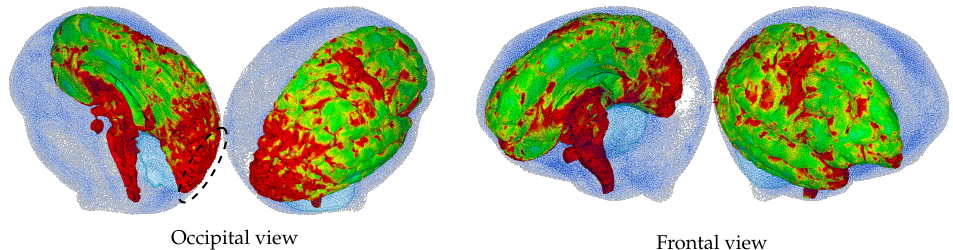
Figure 7. The stress distribution (Scaled; blue: 0, red: max in Wave C) on the brain at the peak of the wave B .